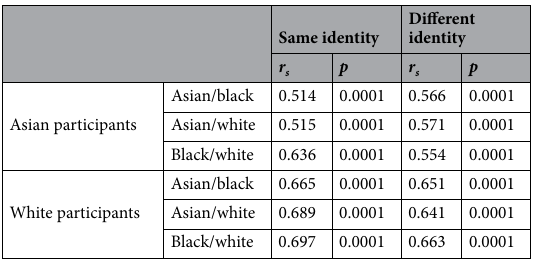
Table 1. Correlation between accuracy on own-race and other-race faces on same identity and different identity trials. The results show that performance on own-race faces strongly predicted performance on other- race faces.